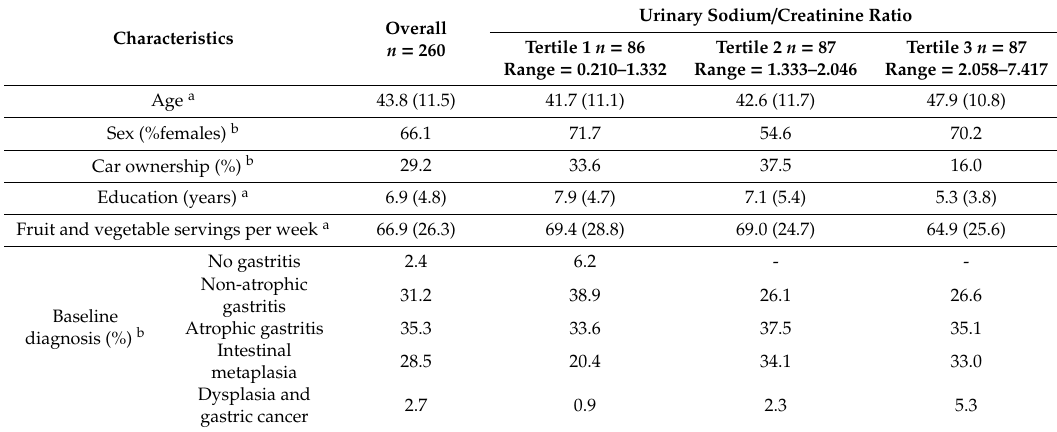
Table 1. Baseline characteristics by tertiles of sodium / creatinine